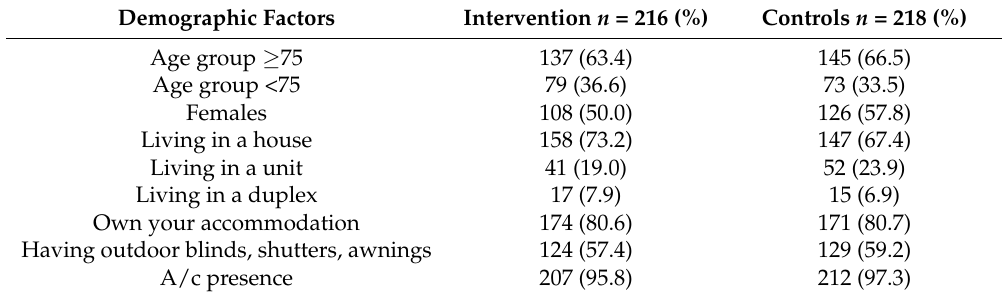
Table 1. Frequency distribution of demographic variables by intervention and control groups.